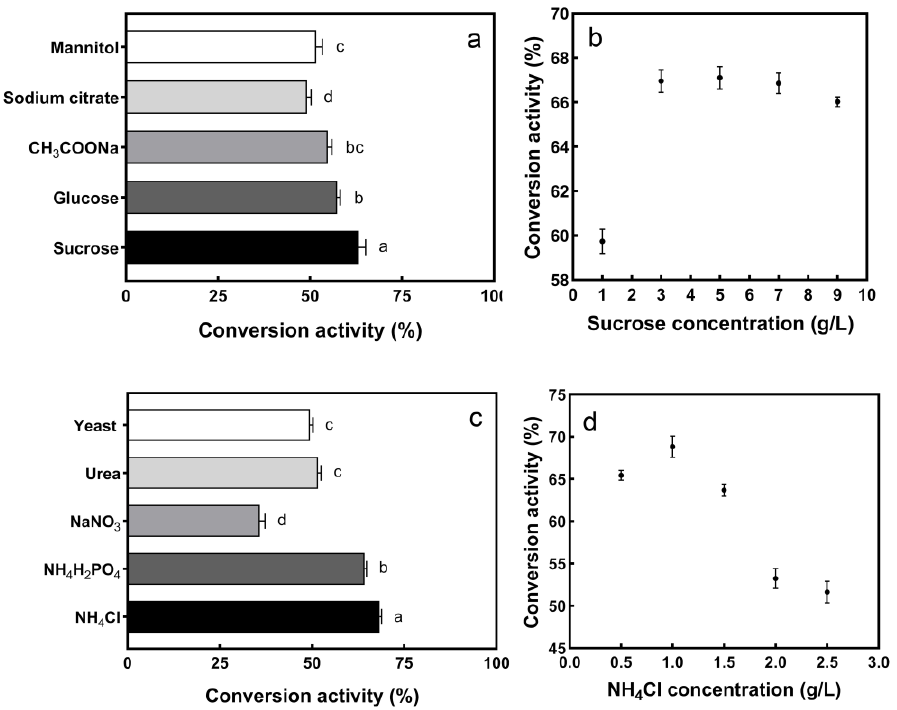
Figure 4. Effect of different carbon nitrogen sources on enzyme conversion activity: ( a ) carbon source, ( b ) sucrose concentration, ( c ) nitrogen source, ( d ) NH 4 Cl concentration. The different letters indicate significant differences ( p < 0.05) between each group.